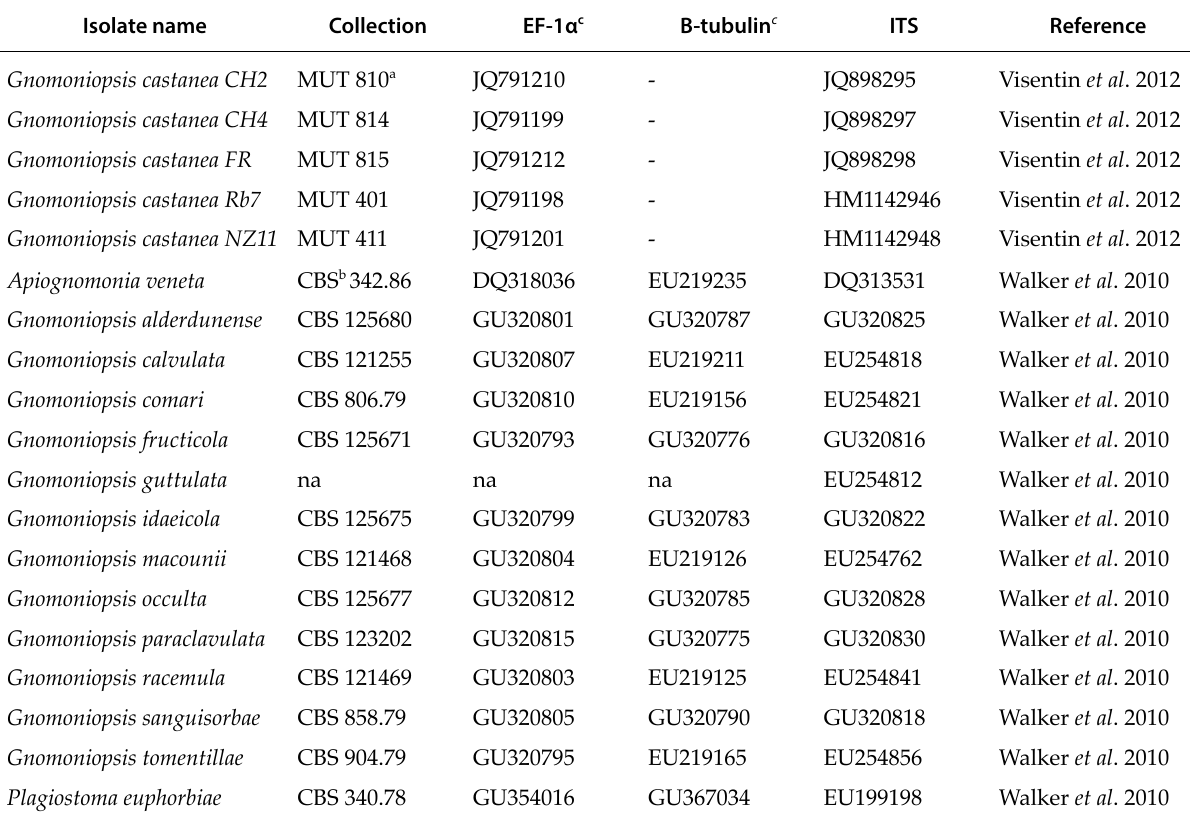
Table 3. Reference strains and GenBank accession numbers for fungi assessed in this